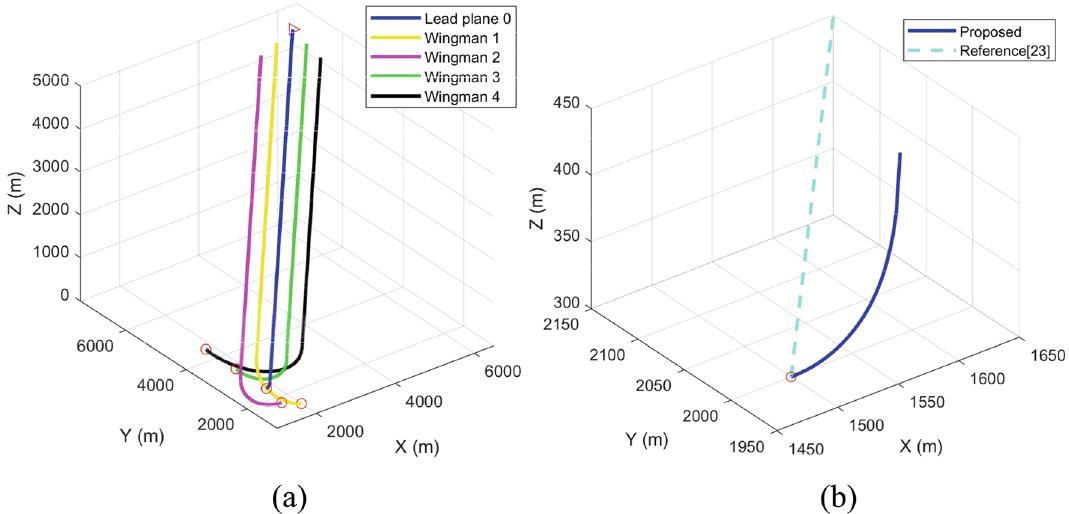
Figure 5. Flight trajectory planning results of the UAV formation flight ( a ) The whole path of the formation; ( b ) The path of the lead plane near the starting